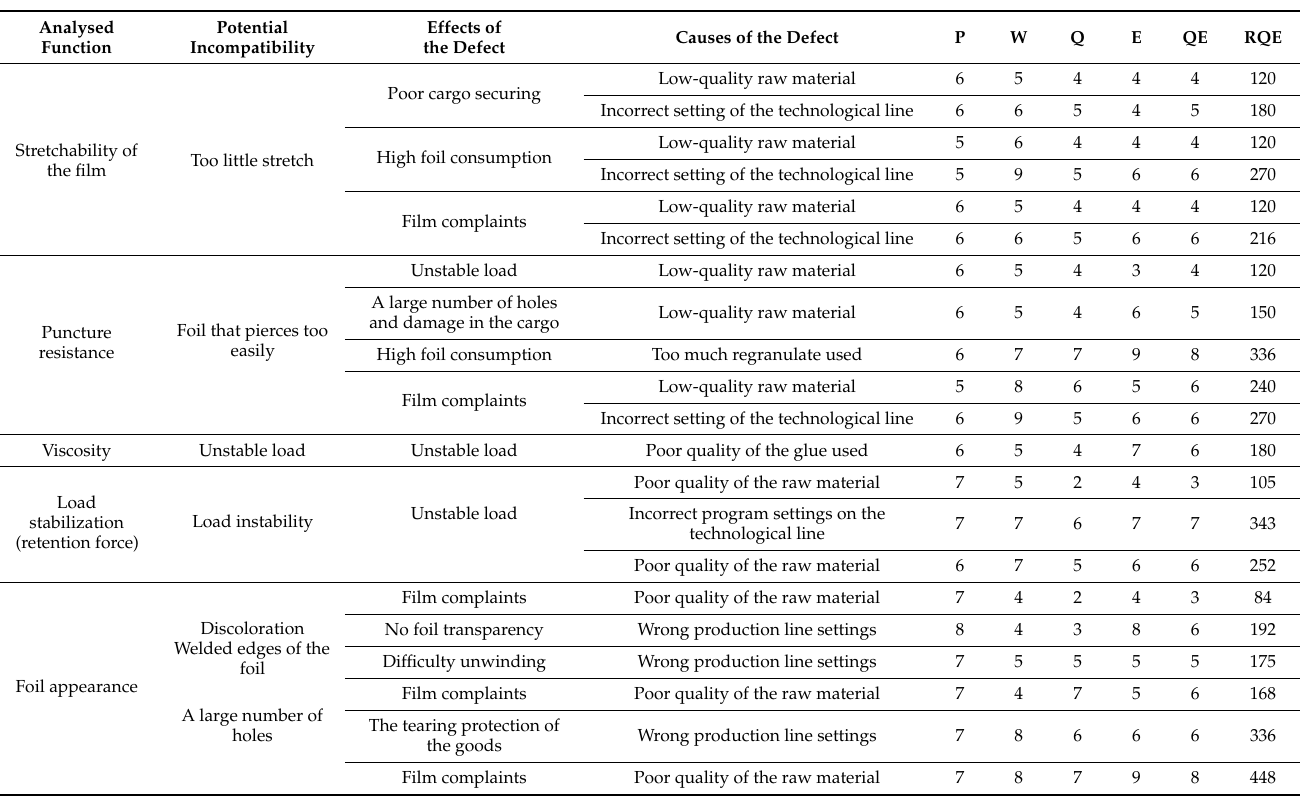
Table 11. Result of the Fuzzy QE-FMEA method for the production of five-layer stretch film for manual